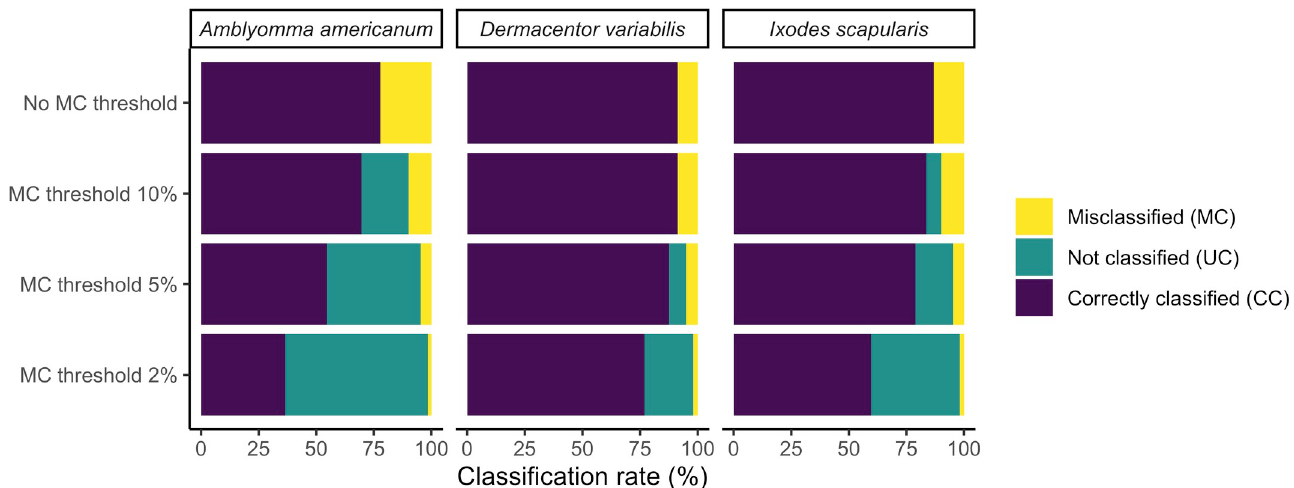
Fig 6. Post-processing of TickIDNet predictions on user-generated test set with species-specific confidence thresholds to increase the correct classification rate (CC) at the cost of more images being returned as “unsure.” Three different sets of thresholds were calculated by applying 10%, 5%, 2% MC bounds to the validation set as described in Goal 2 of Villon et. al [39].